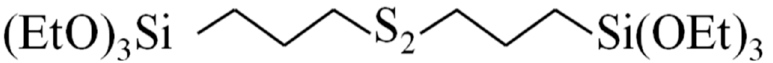
Figure 2. The molecular structure of bis-( γ -triethoxysilylpropyl)-disulfide (TESPD).